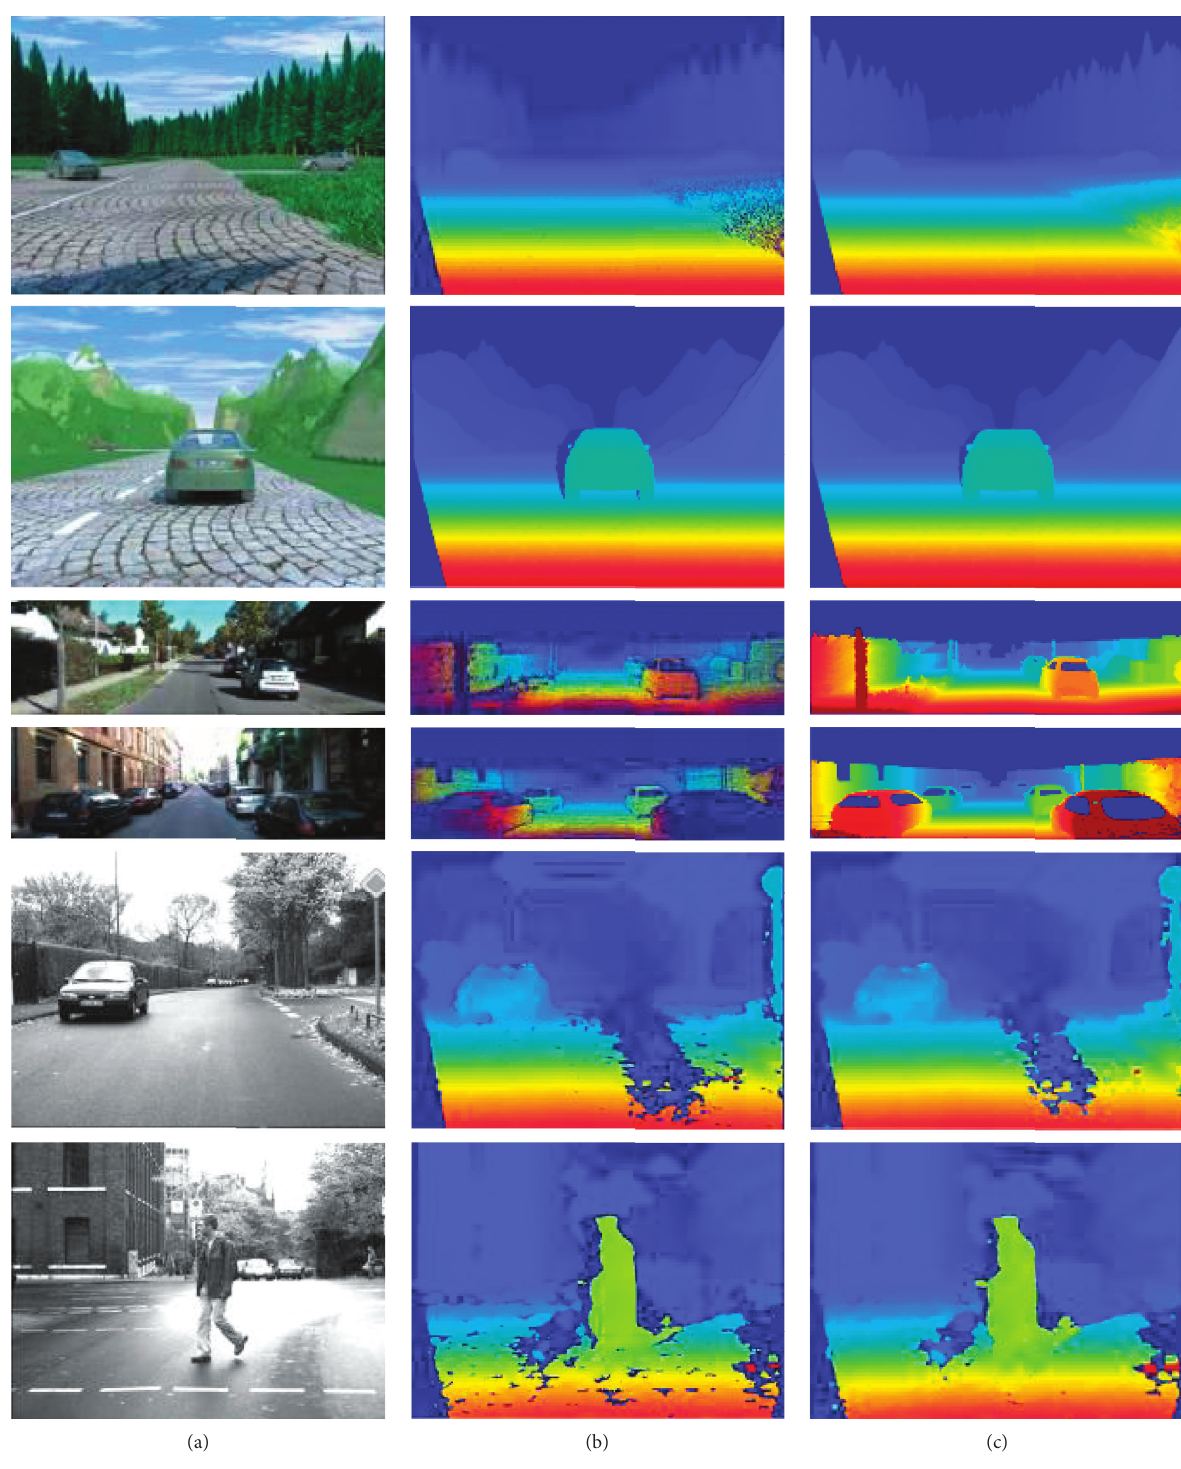
Figure 8: Comparison of disparity figure before and after correction, from top to bottom is Enpeda, KITTI, and Daimler dataset, re- spectively. (a) Original image. (b) Original disparity image. (c) Corrected disparity